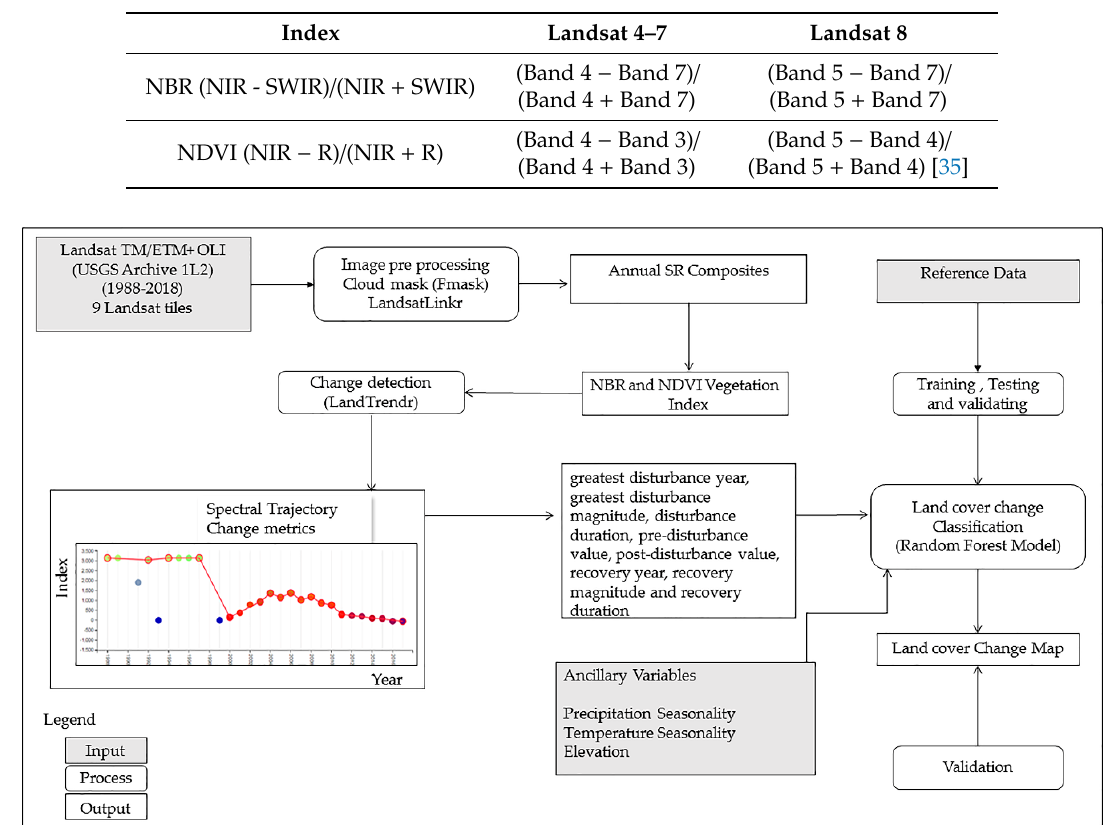
Table 1. Normalised Di ff erence Vegetation Index (NDVI) and Normalised Burn Ratio (NBR) calculation formulas and Landsat bands used for deriving these.